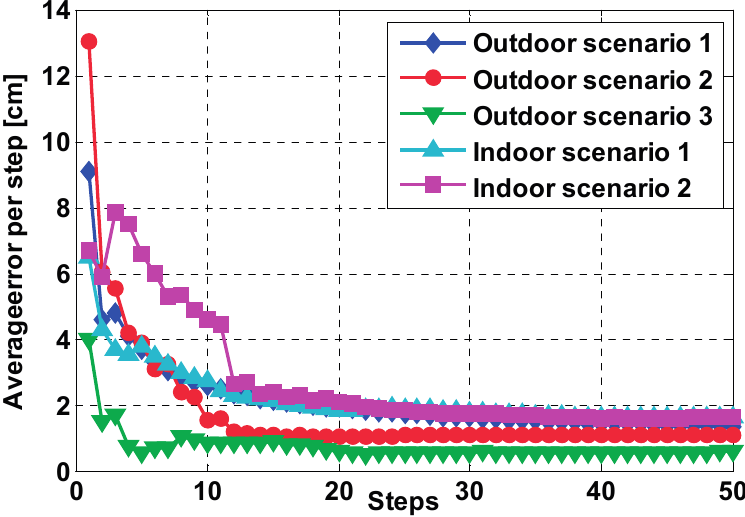
Figure 6. Step length estimation results of proposed training method in different